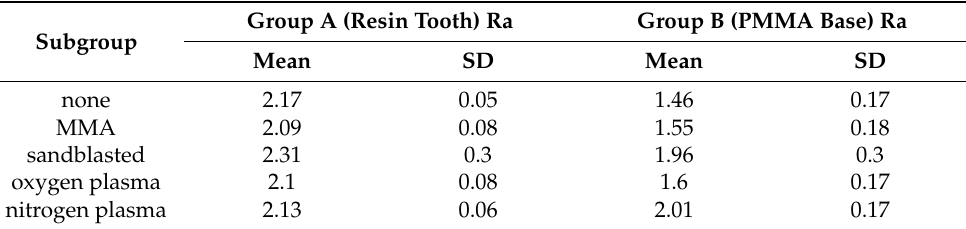
Table 1. Ra values ( µ m) of the different surface modifications. Data are based on n = 1 per group derived from 121 profiles every 25 µ m over an area of 9 mm 2 in the center of the specimen.